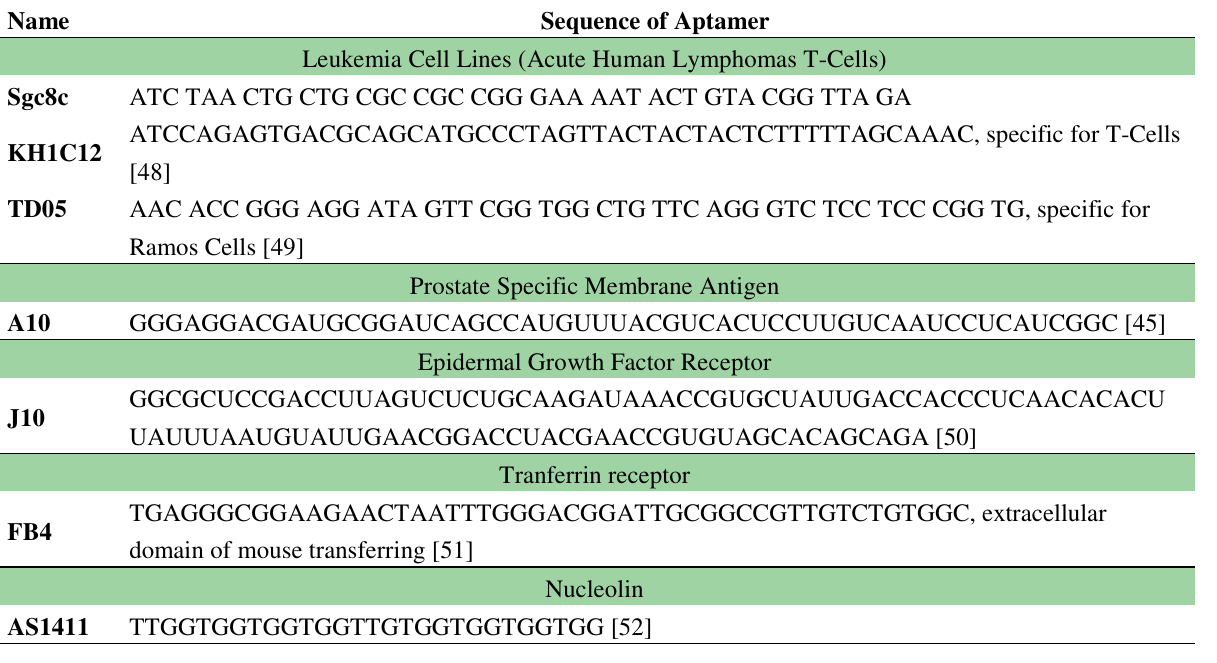
Table 1. Commonly used aptamer sequences used in targeting nanoparticles.